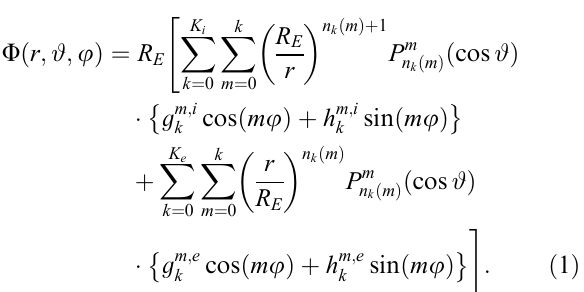
(cid:136) 20 (cid:14) and k (cid:136) 0 ; . . . ; 8 (cid:134) . 0